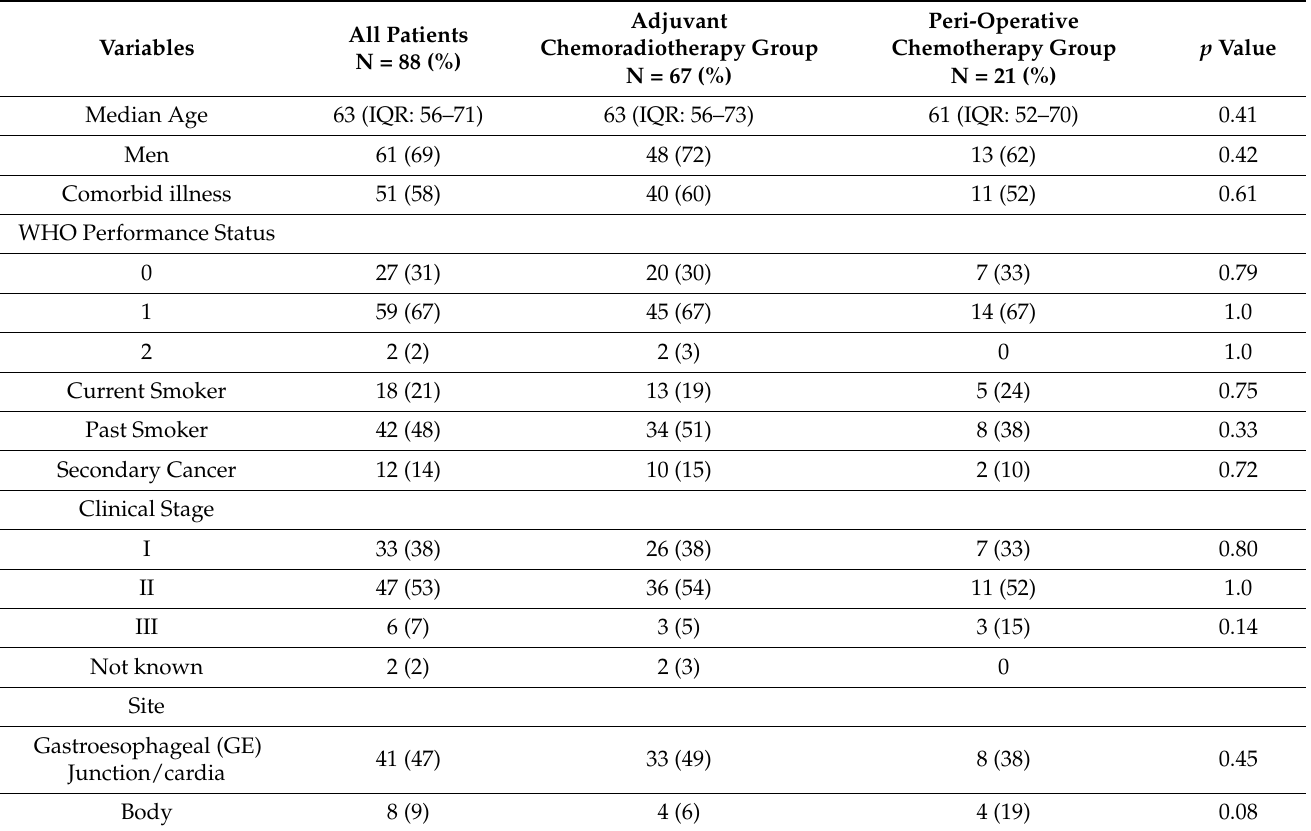
Table 1. Characteristics of patients who received adjuvant chemoradiotherapy versus perioperative chemotherapy.